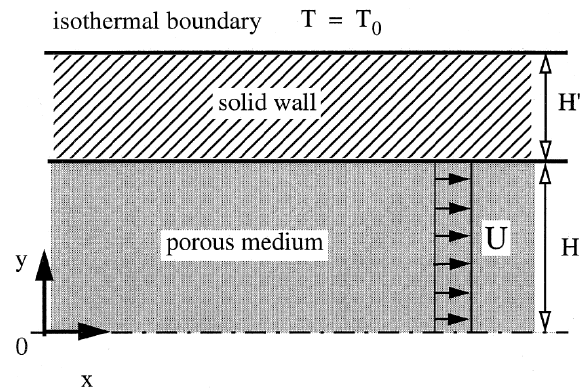
Figure 8. Physical problem considered by Nield and Kuznetsov